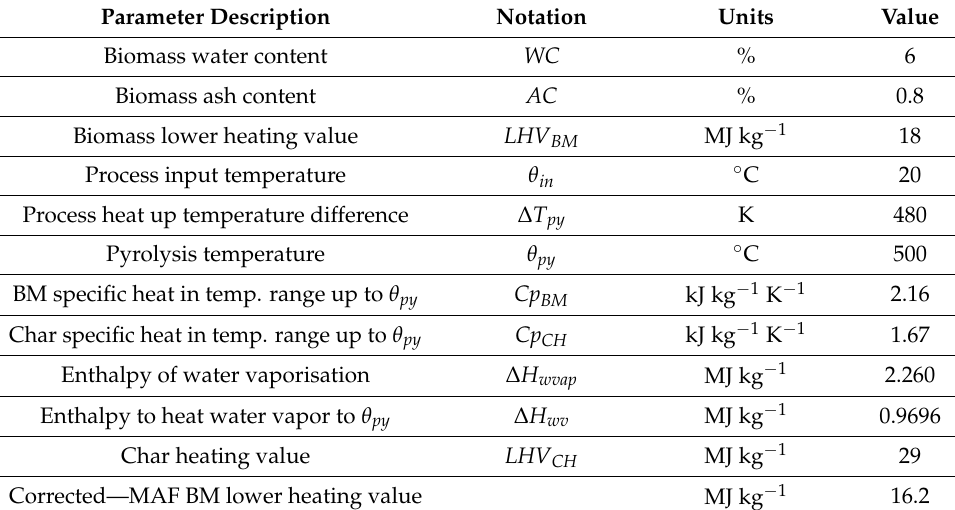
Table 1. Overview of the material and process parameters for the